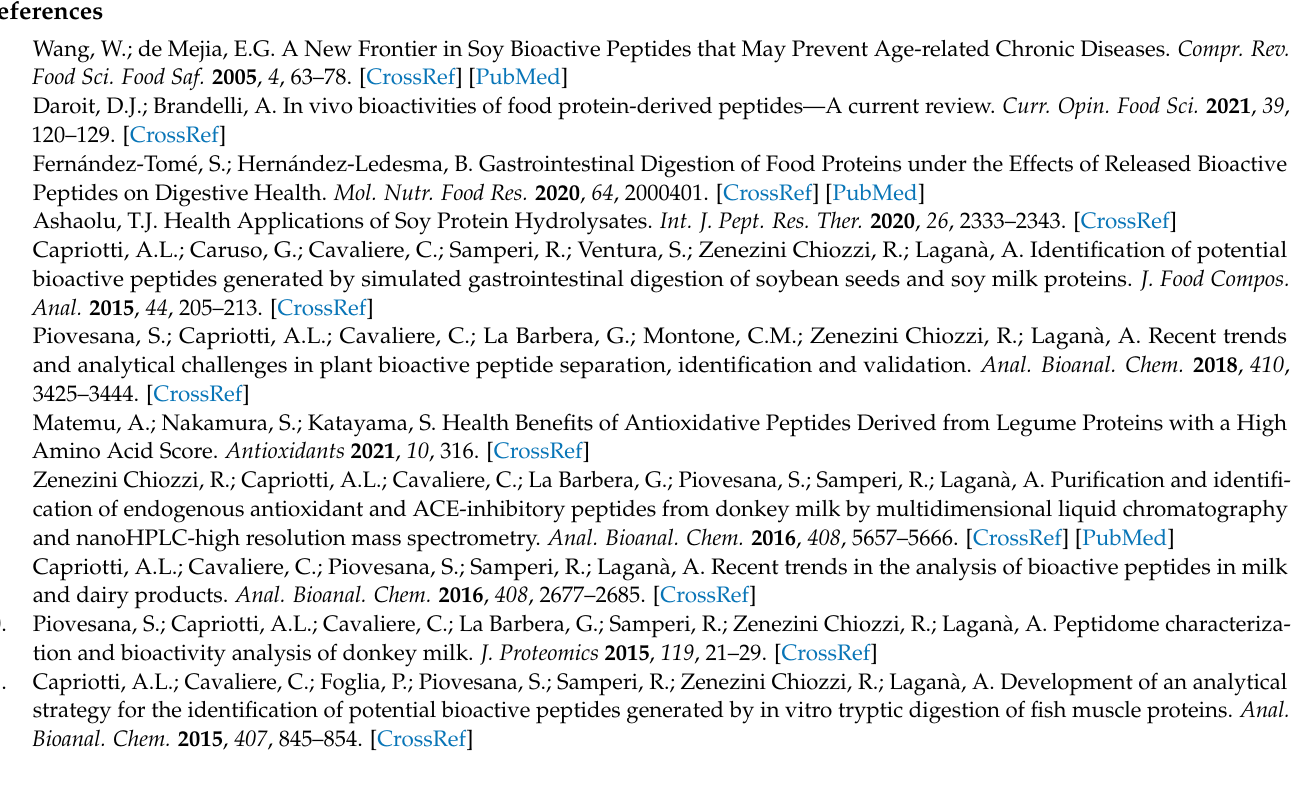
Protocol III: this is reported in the experimental section, and was used for this